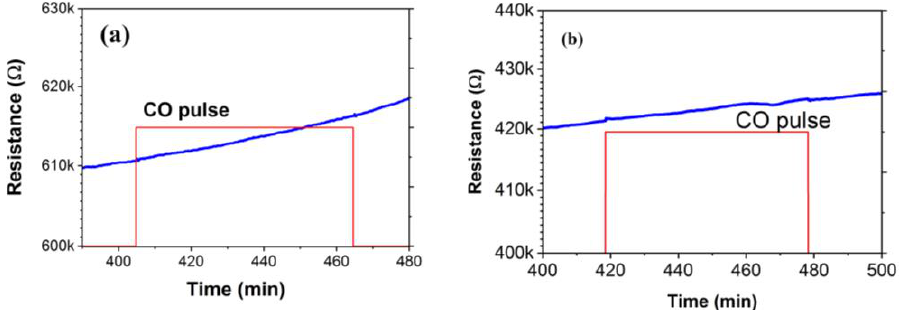
Figure 11. Change of S2 sample resistance in response to CO pulse of concentration 20 ppm at 50% RH and at sensor temperatures of ( a ) 48 °C and ( b ) 100 °C.